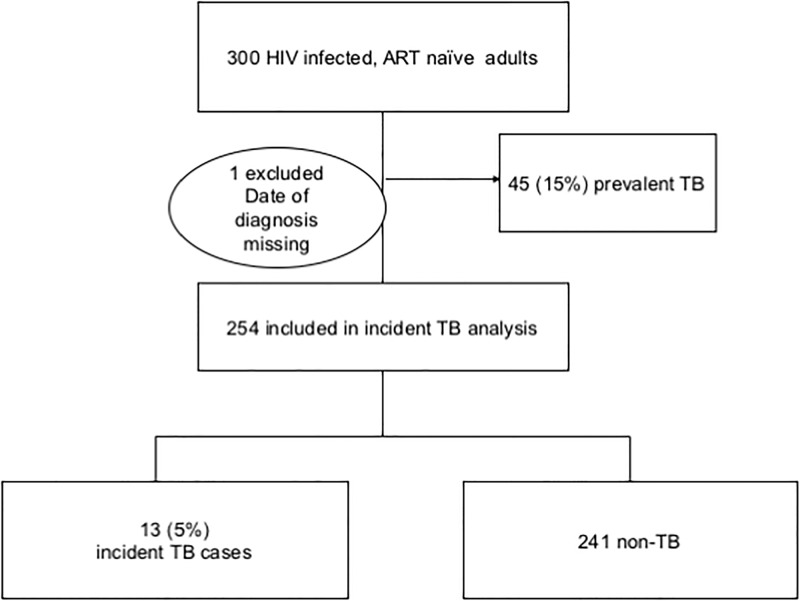
Participant flow diagram of individuals enrolled in the incident TB cohort analysis.Forty-six individuals were excluded from further analysis: 45 had TB at baseline (prevalent TB) and one did not have a recorded date of diagnosis.